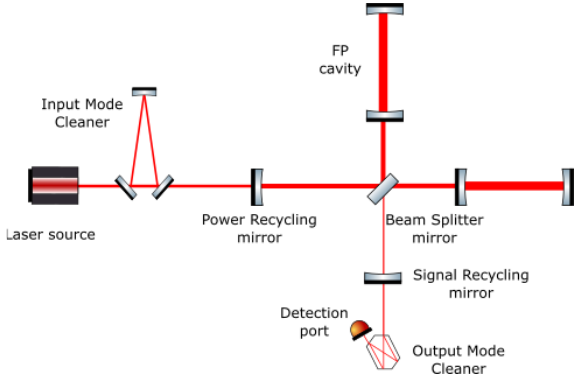
Figure 1. Schematic drawing of the Virgo detector in which the main optical components are shown as: the Fabry-Perot cavities (FP cavities), 3km long orthogonal arms, the Power Recycling mirror (PR), the Signal recycling mirror (SR), the Beam Splitter mirror (BS) which splits the incoming beam generated by the laser source in the two cavities and defines the interference condition at the detection port. Moreover two additional cavities are implemented to clean and stabilize the input and output beam, the Input Mode Cleaner (IMC) and the Output Mode Cleaner (OMC)